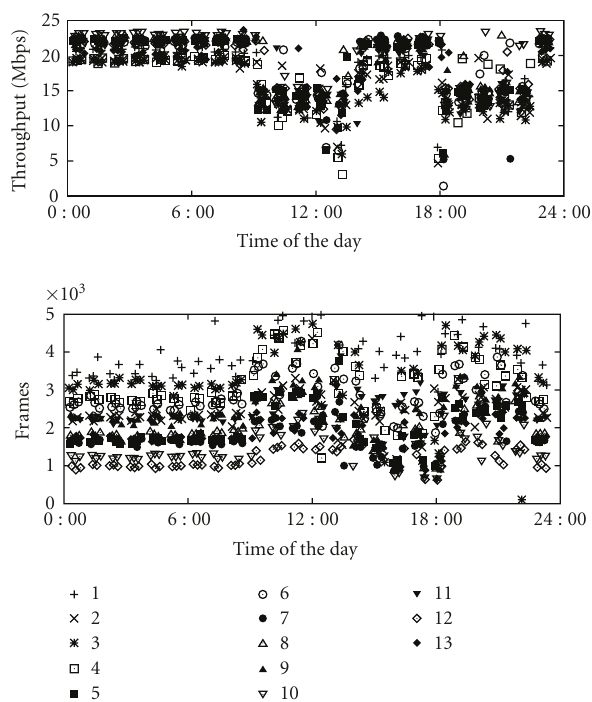
Figure 5: Performance of 802.11g in our testbed for each available